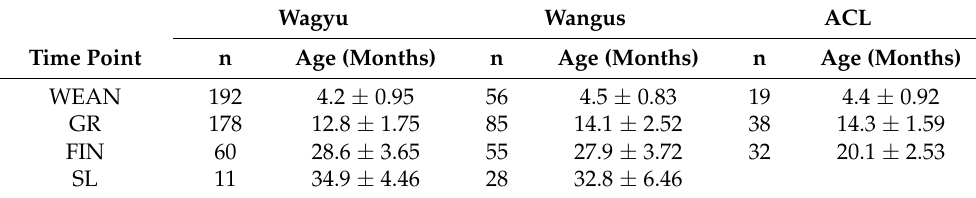
Table 3. Number and ages of fattening steers at each of the study’s time points (transversal approach). Wagyu Wangus ACL Time Point